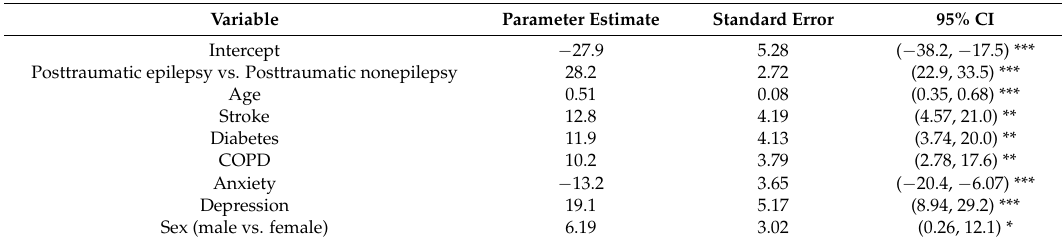
Table 5. Stepwise regression analysis for average hospital days per year (all-cause admission) through propensity-score matching.